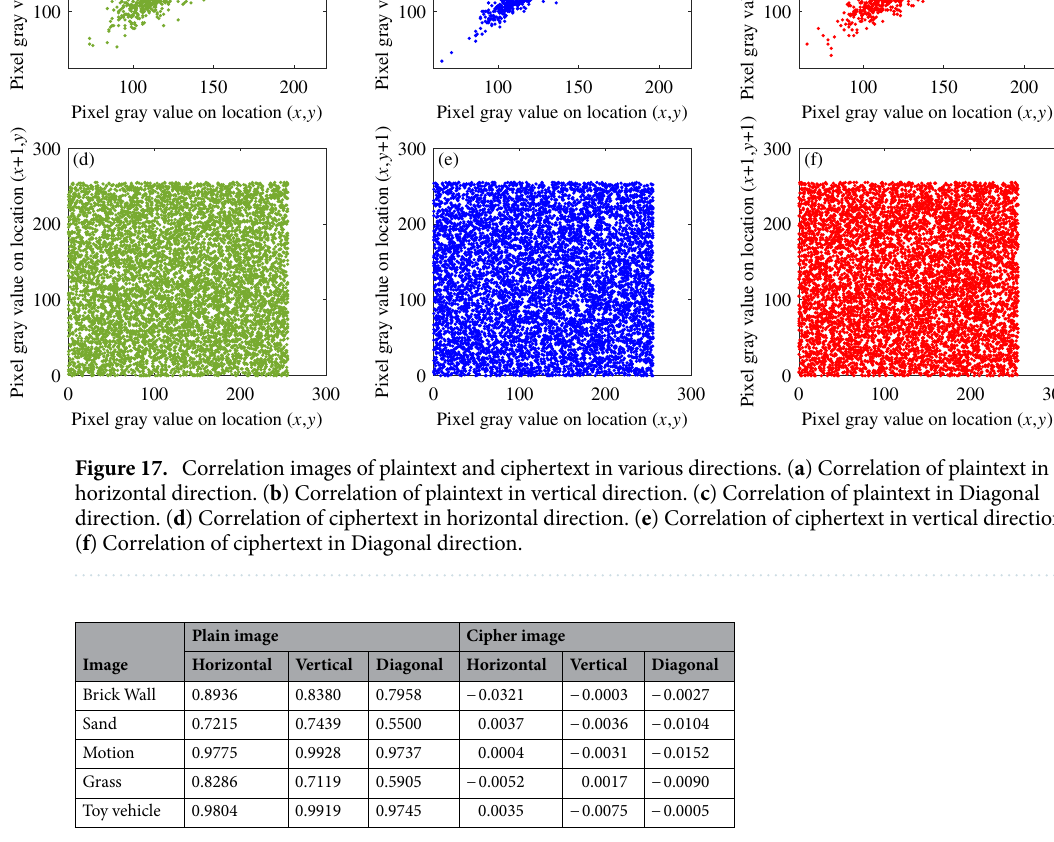
Table 10. Correlation coefficient analysis of different image correlation